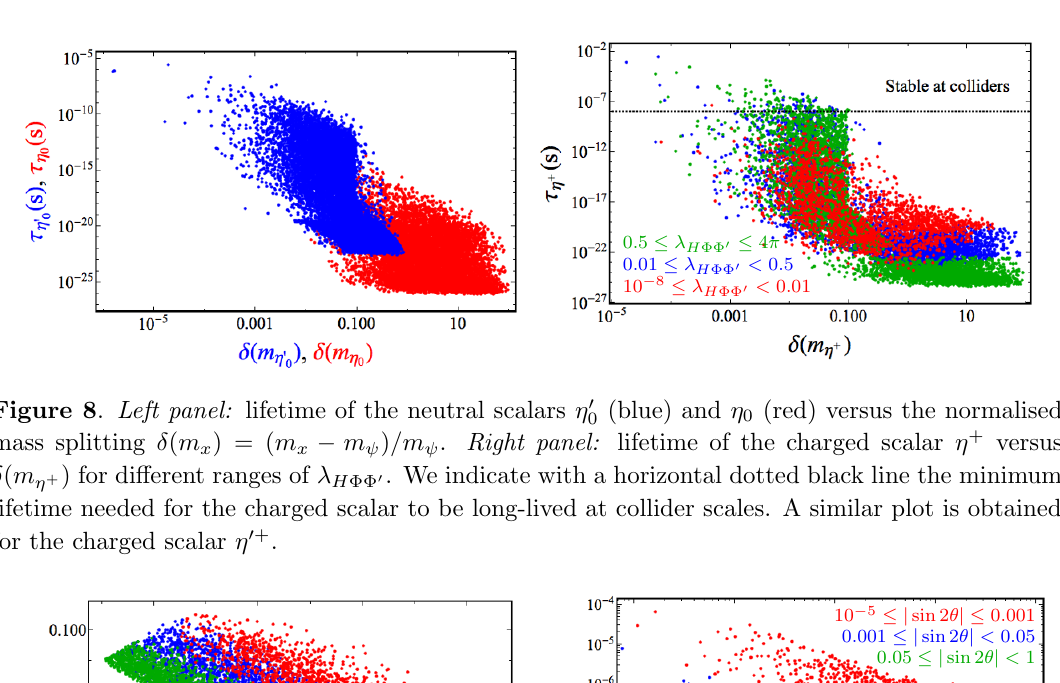
Figure 7 . Normalised mass splitting (cid:14) ( m x ) = ( m x (cid:17) + , in blue, and of the neutral scalar (cid:17) 0 superimposed over part of the blue one.